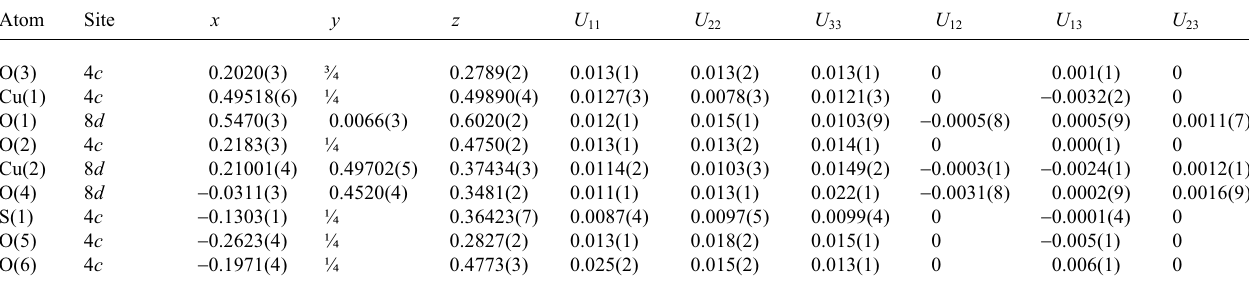
Table 3. Atomic coordinates and displacement parameters (in Å 2 )